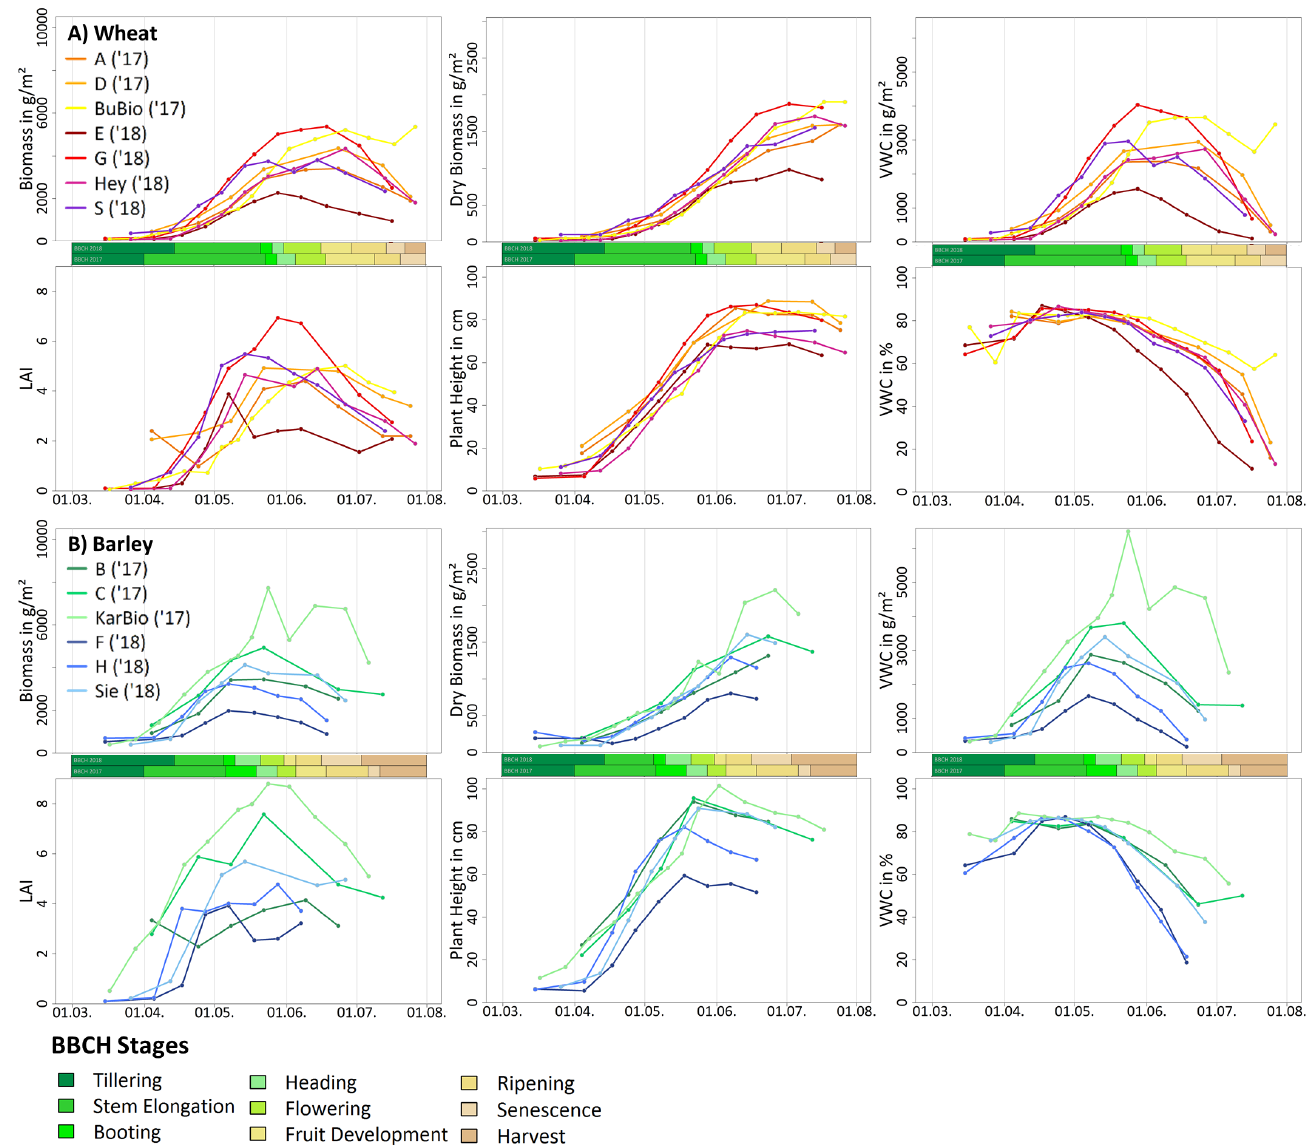
Figure 4. Temporal development of crop parameters for all wheat fields ( A ) and barley fields ( B ): the greenish and brownish bars between the plots represent the BBCH stages in 2017 (lower bar) and 2018 (upper